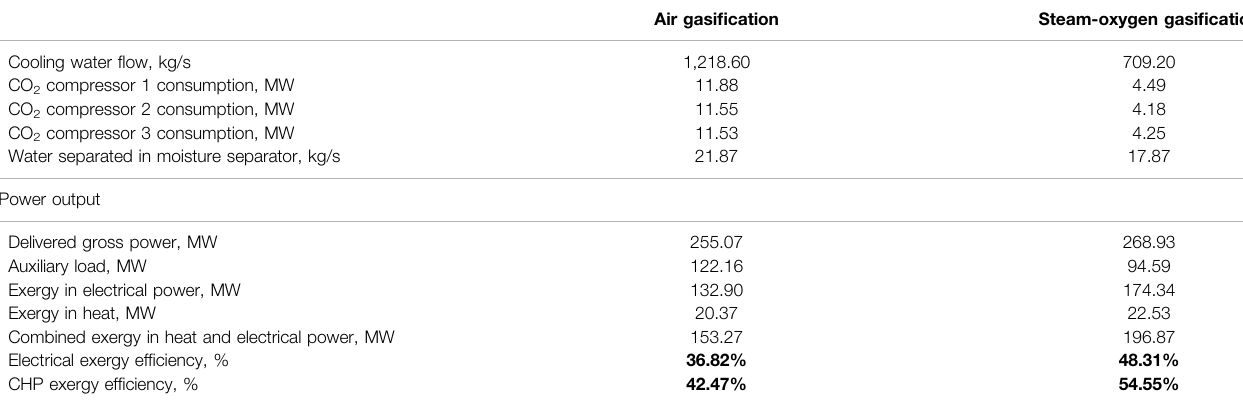
TABLE 6 | ( Continued ) Model results of the air gasi fi cation case — a comparison with the steam-oxygen gasi fi cation case.